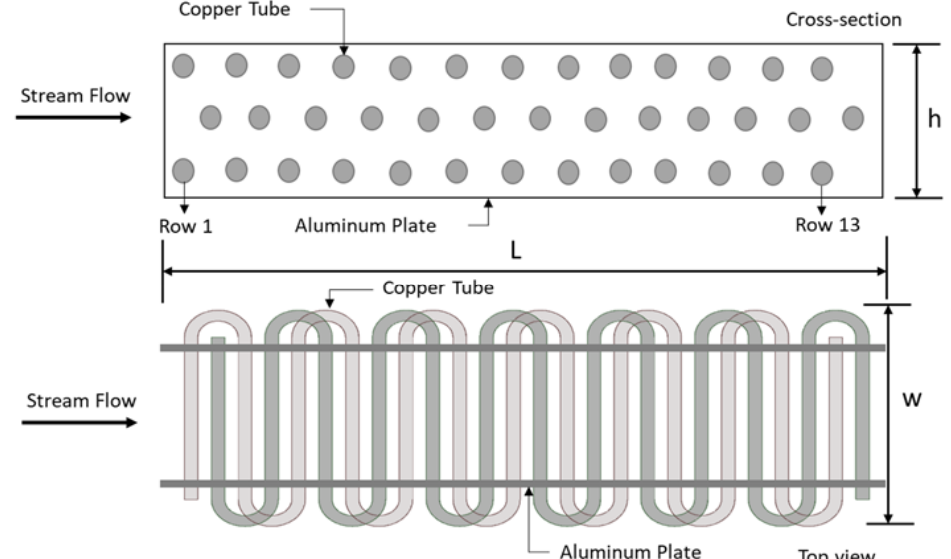
Figure 3. Schematic diagram of the heat exchanger (figure not drawn to scale).